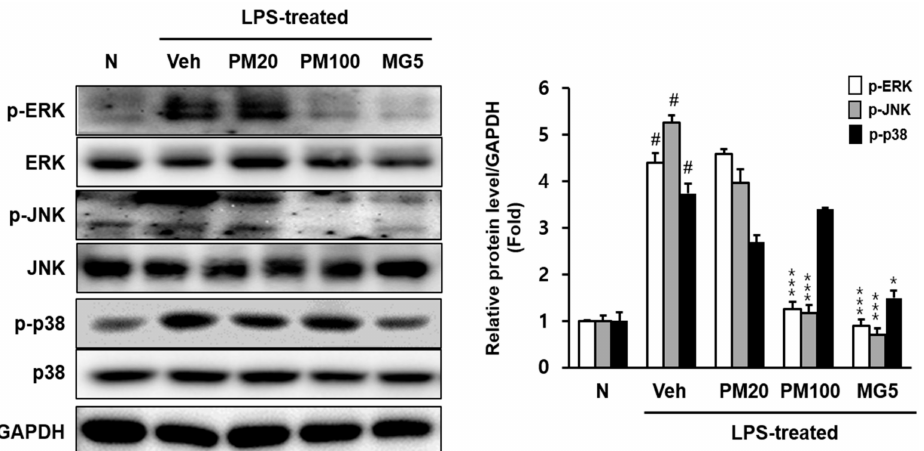
Figure 4. Total and phosphorylated p-ERK, p-JNK, and p-p38 protein levels in the kidney. N, normal mice; Veh, vehicle-administered and LPS-treated mice; PM20, P. su ff ruticosa 20 mg / kg body weight-administered and LPS-treated mice; PM100, P. su ff ruticosa 100 mg / kg body weight-administered and LPS-treated mice; and MG5, methyl gallate 5 mg / kg body weight-administered and LPS-treated mice. The protein levels of p-ERK, p-JNK, and p-p38 were quantified using CS analyzer software. Respective total-form proteins were used as loading control. A representation of three experiments that yielded similar results. One-factor ANOVA: # p < 0.05 versus normal mice; * p < 0.05 and *** p < 0.001 versus veh (vehicle-administered and LPS-treated mice). Bars indicate standard errors of means